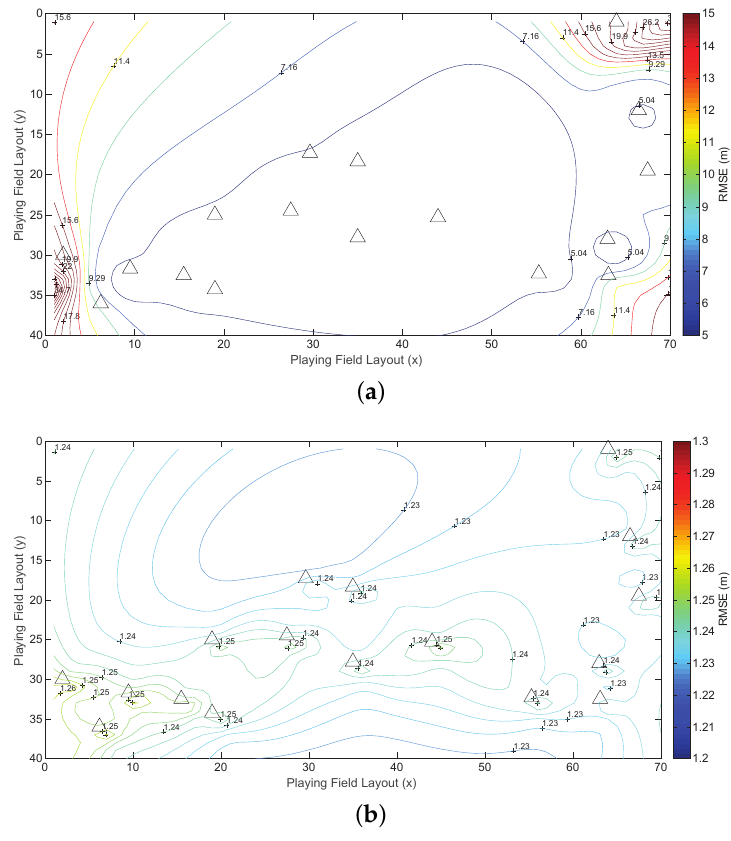
Figure 10. The real system evaluation. ( a ) SPED without prior knowledge; ( b ) SPED with prior